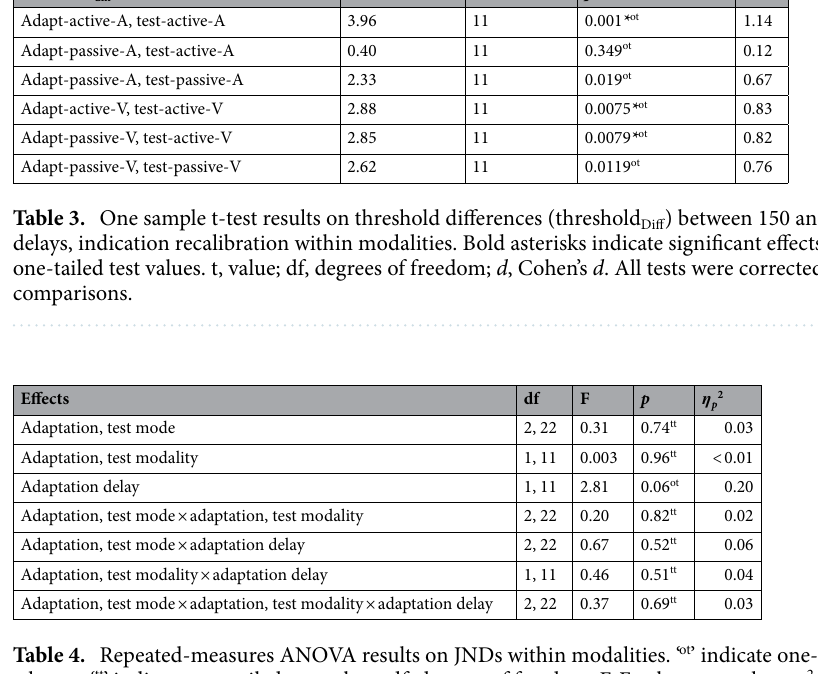
Table 4. Repeated-measures ANOVA results on JNDs within modalities. ‘ ot ’ indicate one-tailed test values whereas ‘ tt ’ indicate two-tailed test values. df, degrees of freedom; F, F value, p , p value; ƞ p 2 partial eta-squared.